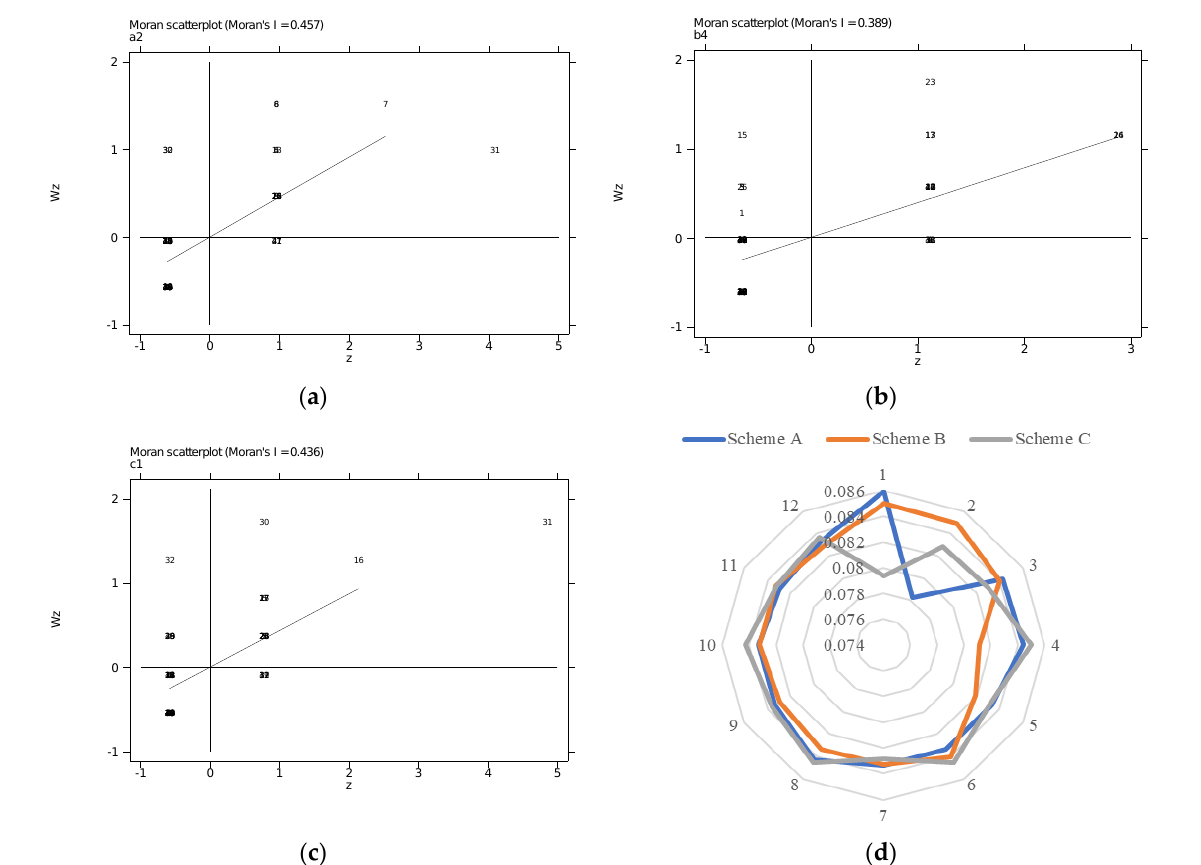
Figure 6. The maximum values of the global Moran’s I and the weighting values based on Moran’s I; ( a ) the maximum Moran’s I value based on Scheme A; ( b ) the maximum Moran’s I value based on Scheme B; ( c ) the maximum Moran’s I value based on Scheme C; ( d ) the weighting values based on Moran’s I.